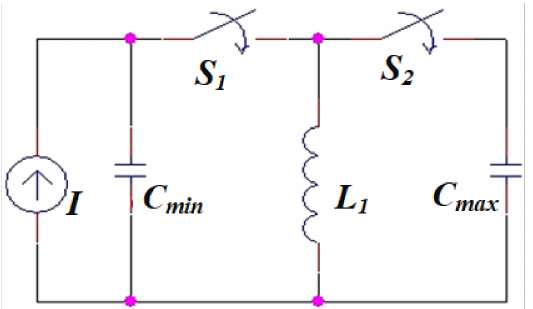
Figure 7. The behavioral circuit model of the electrostatic MEMS